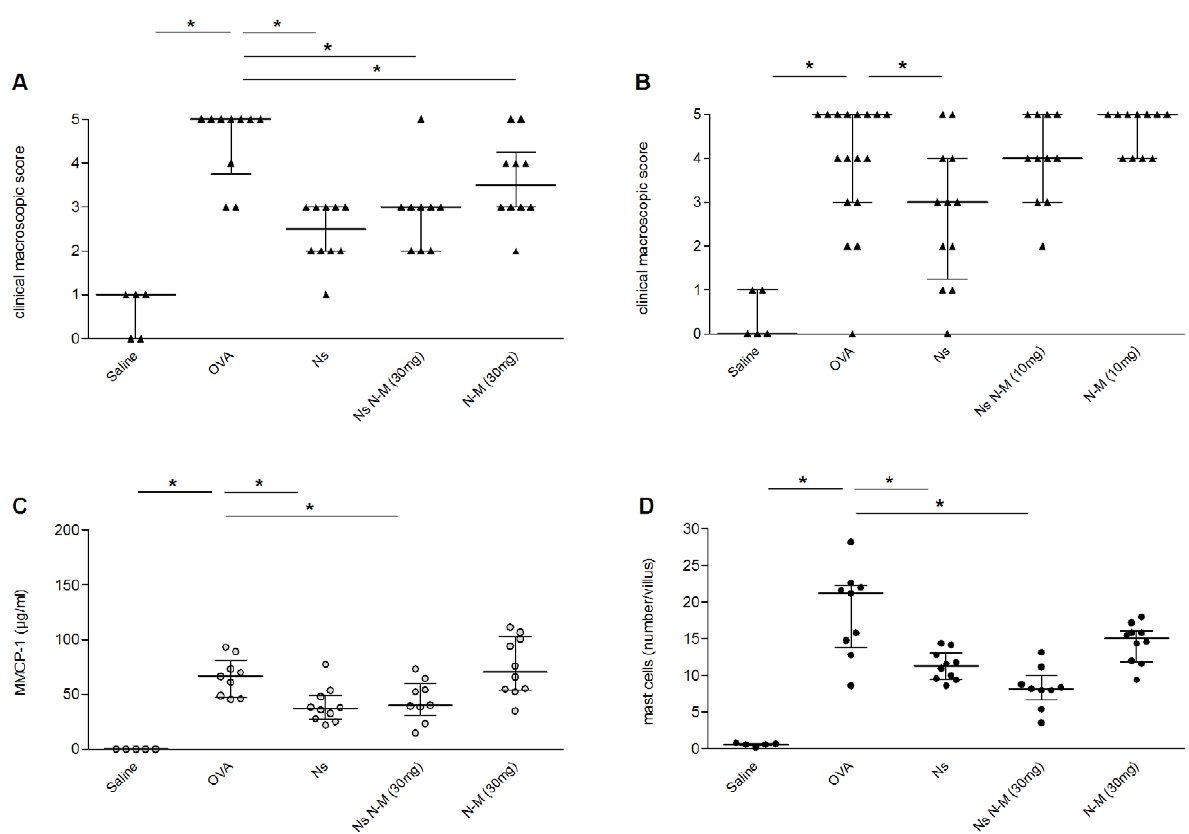
Figure 1. N.sativa seed extract decreases clinical macroscopic scores and immune parameters in OVA-allergic mice. OVA-sensitized mice were challenged with saline (Saline), OVA (OVA), or with OVA after intragastric administration of N. sativa seed extract (Ns) with the OR antagonist naloxone-methiodide pre-treatment at the dose indicated (Ns N-M), or with naloxone-methiodide alone (N-M). Panels A and B represent the median of clinical macroscopic scores at sacrifice. Panels C and D show the plasma concentration of MMCP-1 ( C ) and the numbers of mast cells per intestinal villus ( D ) at sacrifice. Each dot represents the corresponding value for one animal and the bars represent the median with interquartile range, *= p , 0.05; n=5–19.